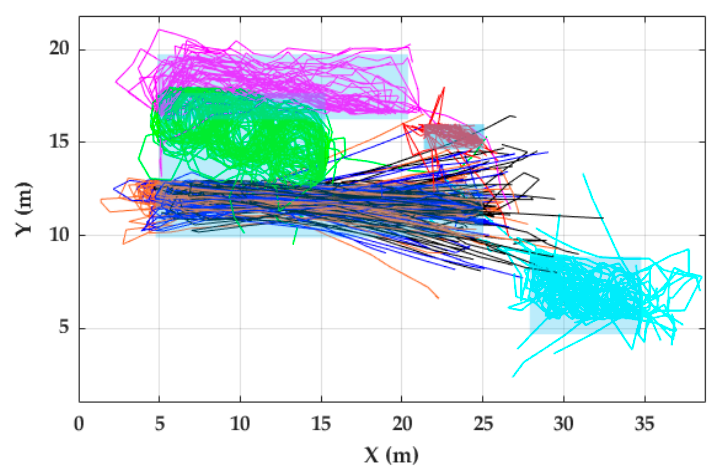
Figure 13. Trajectory reconstruction of non-circuit activities for all 56 participants of the FAU dataset. Black, blue and orange lines denote R-20, J-20, and W-20, respectively. Red, green, violet and light green lines represent W-Cards, W-Slalom, W-Posters, and W-Tables, respectively. Gray rectangles represent zones where all the strides related to certain activity should take place.